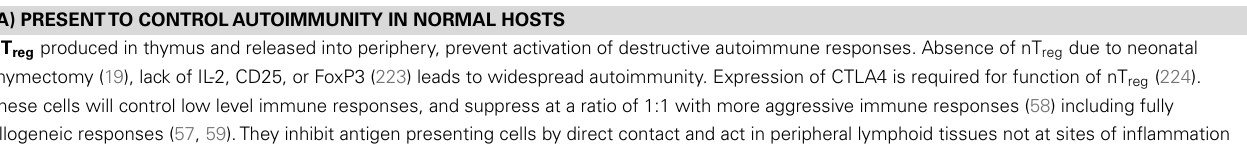
Table 1 | Subclasses of CD4 + T cells with regulatory